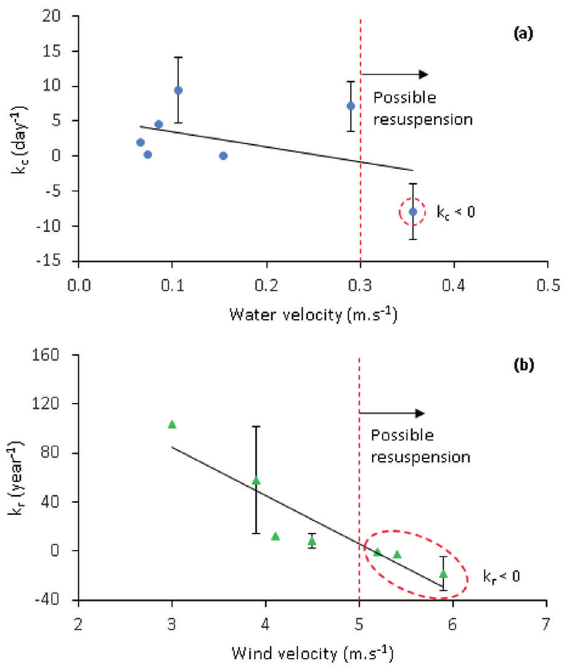
Figure 7 - Inverse dependence of P decay coefficient on water and wind velocities obtained for (a) the channel and (b) the reservoir, respectively, indicating potential thresholds (dashed lines) for resuspension of bed sediments/internal P loading. Solid lines are curves fitted to the data and error bars represent standard